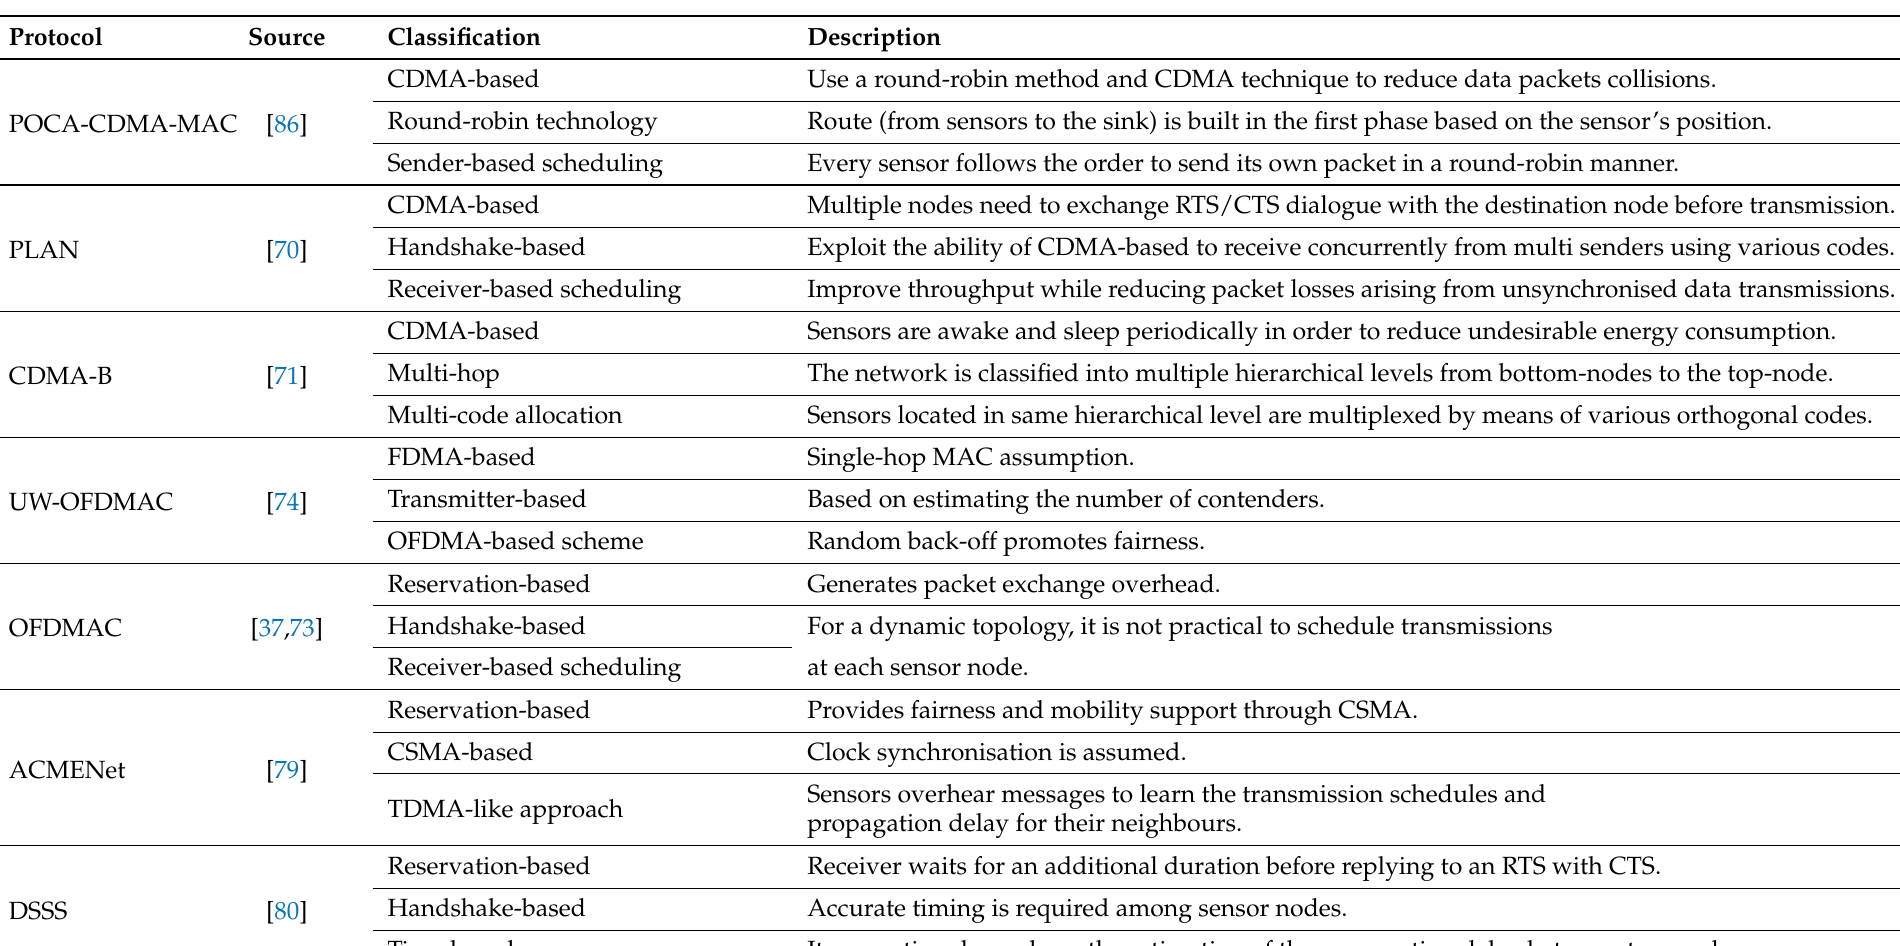
Table 2. Summary of contention-free MAC protocols with different scheduling disciplines for underwater acoustic sensor